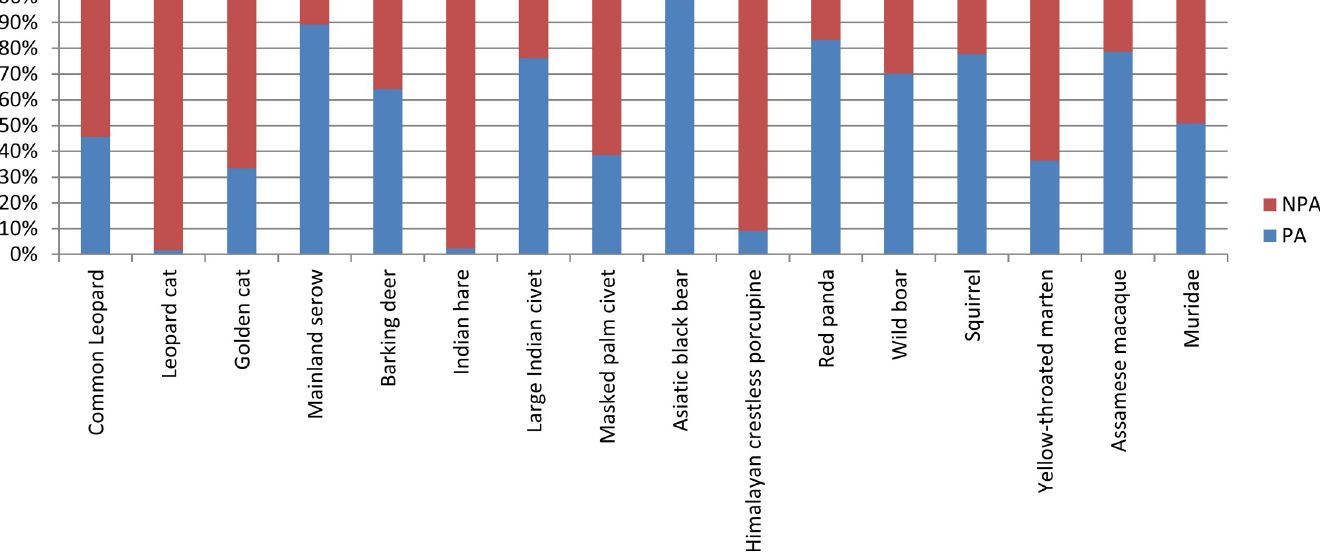
Fig 2. Proportion of na ï ve occupancy of species in protected area and non-protected area forest ranges of Darjeeling district, West